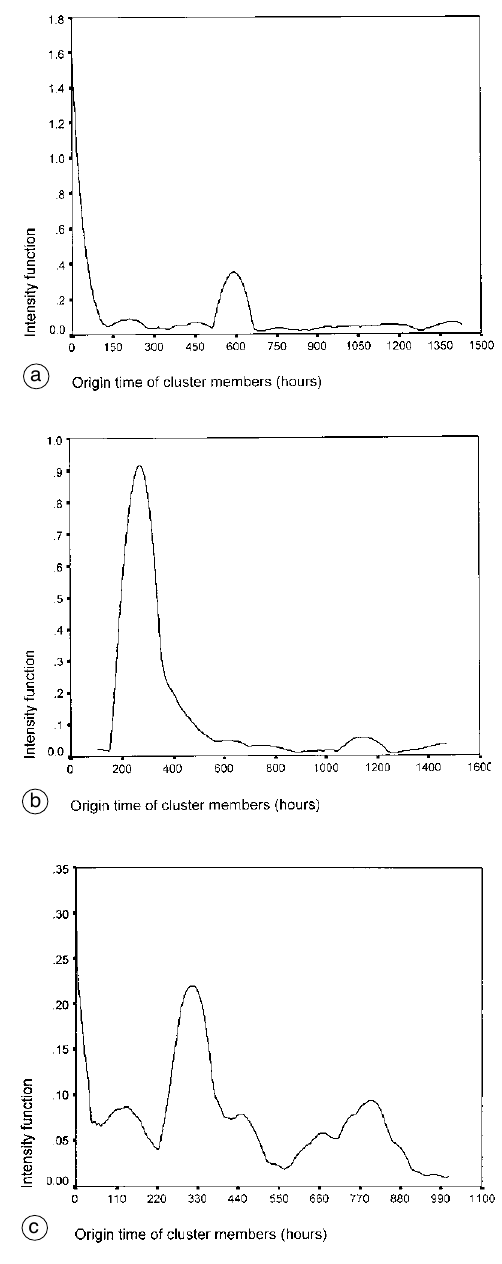
Fig. 19a-c. Intensity estimations for important clusters: a) December 1995; b) May 1997, and c) May- June 1998.